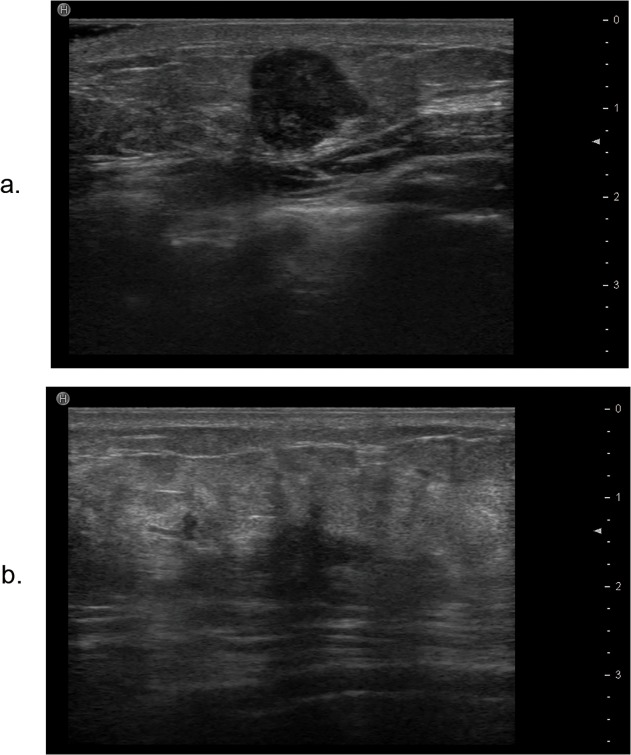
The tumor margin on ultrasound.a. It shows that there is a slight lobulated margin of normal-like breast tumor. b. The ultrasound image of a basal-like breast cancer shows that the tumor margin is angular and speculated.